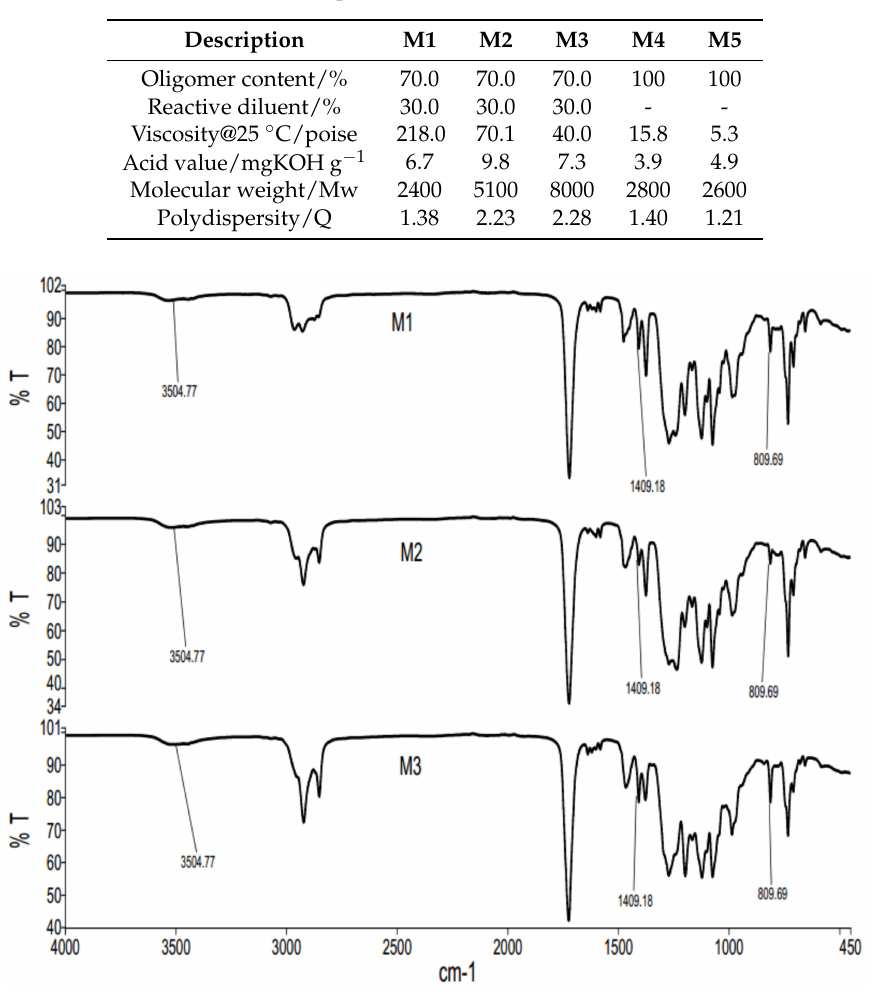
Figure 2. FTIR spectra of the M1, M2, and M3